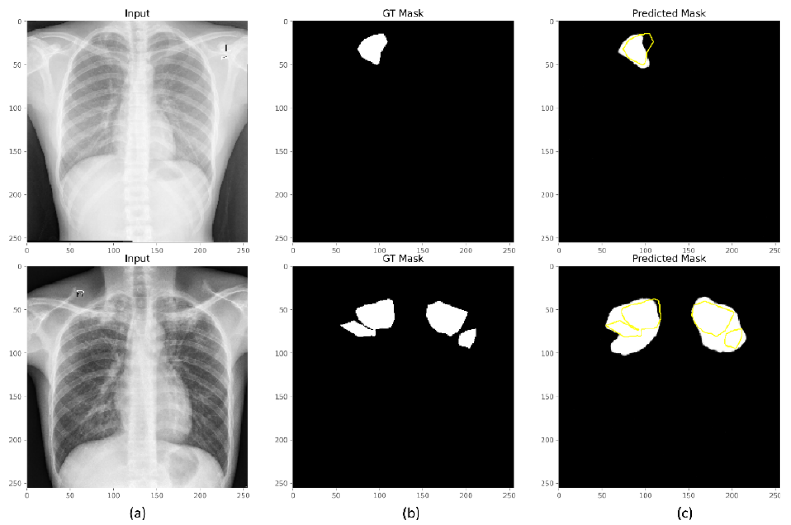
Figure 10. Predictions of the VGG ‐ 16 ‐ based U ‐ Net model trained with the Focal Tversky + BU loss for sample CXR instances with unknown and other labels. ( a ) Input CXRs; ( b ) GT masks, and ( c ) predicted masks. The region highlighted in yellow denotes the contour of the GT masks.